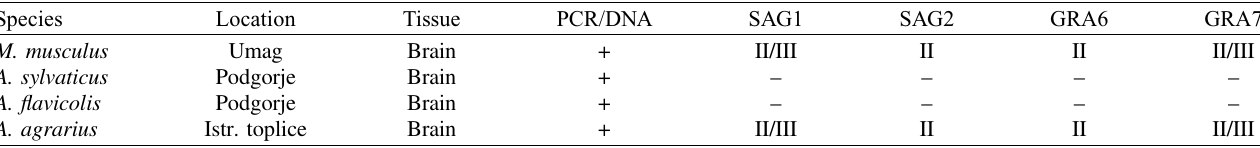
Table 1. qPCR and RFLP PCR results.